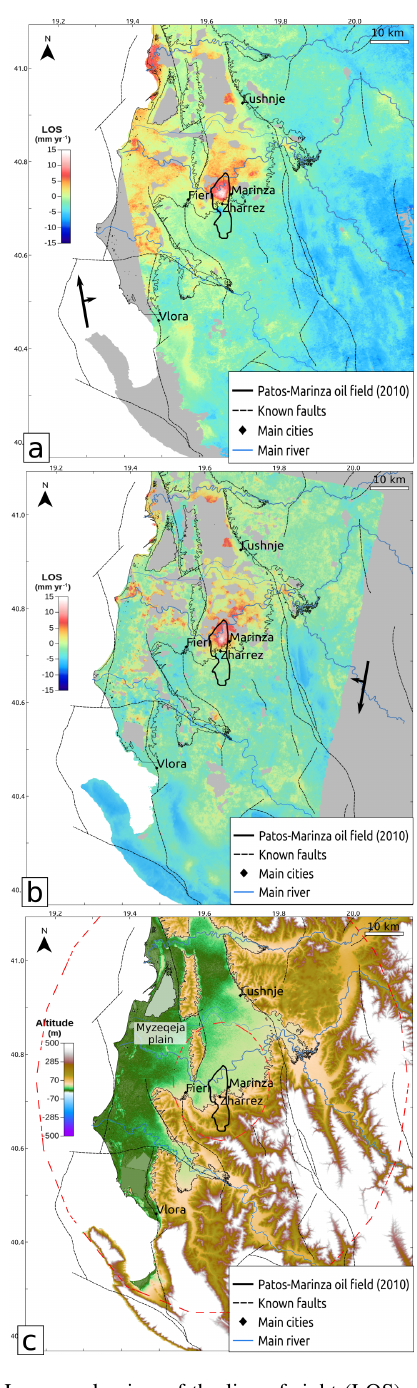
Figure 5. Large-scale view of the line-of-sight (LOS) average ve- locity maps (positive values correspond to motion away from satel- lite, i.e., mostly subsidence) from time series analysis of InSAR data along ascending (a) and descending (b) tracks, together with regional topography (c) . The Patos-Marinza contour is plotted from BCP (2010). Red dotted ellipses are the 15 and 50km radii areas around the center of the oil field used for moment rate calculation in Figs. 3 and